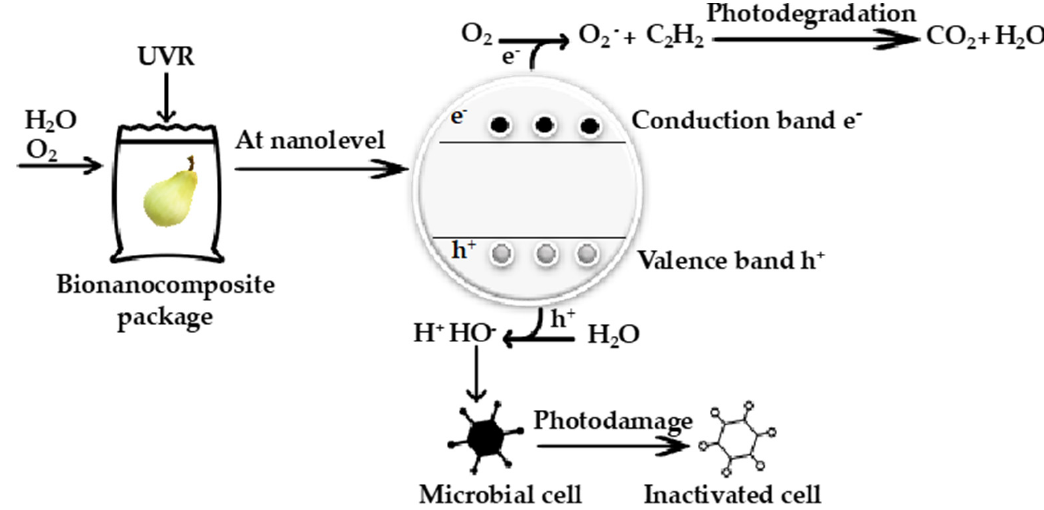
Figure 6. AFP mechanism of action. Adapted from reference [16].